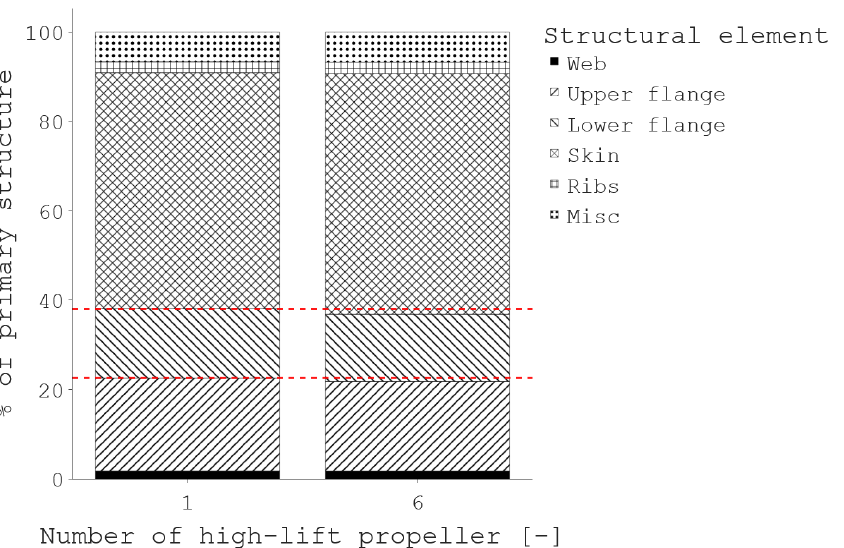
Figure 7. Effect of the number of engines on the primary structure mass.